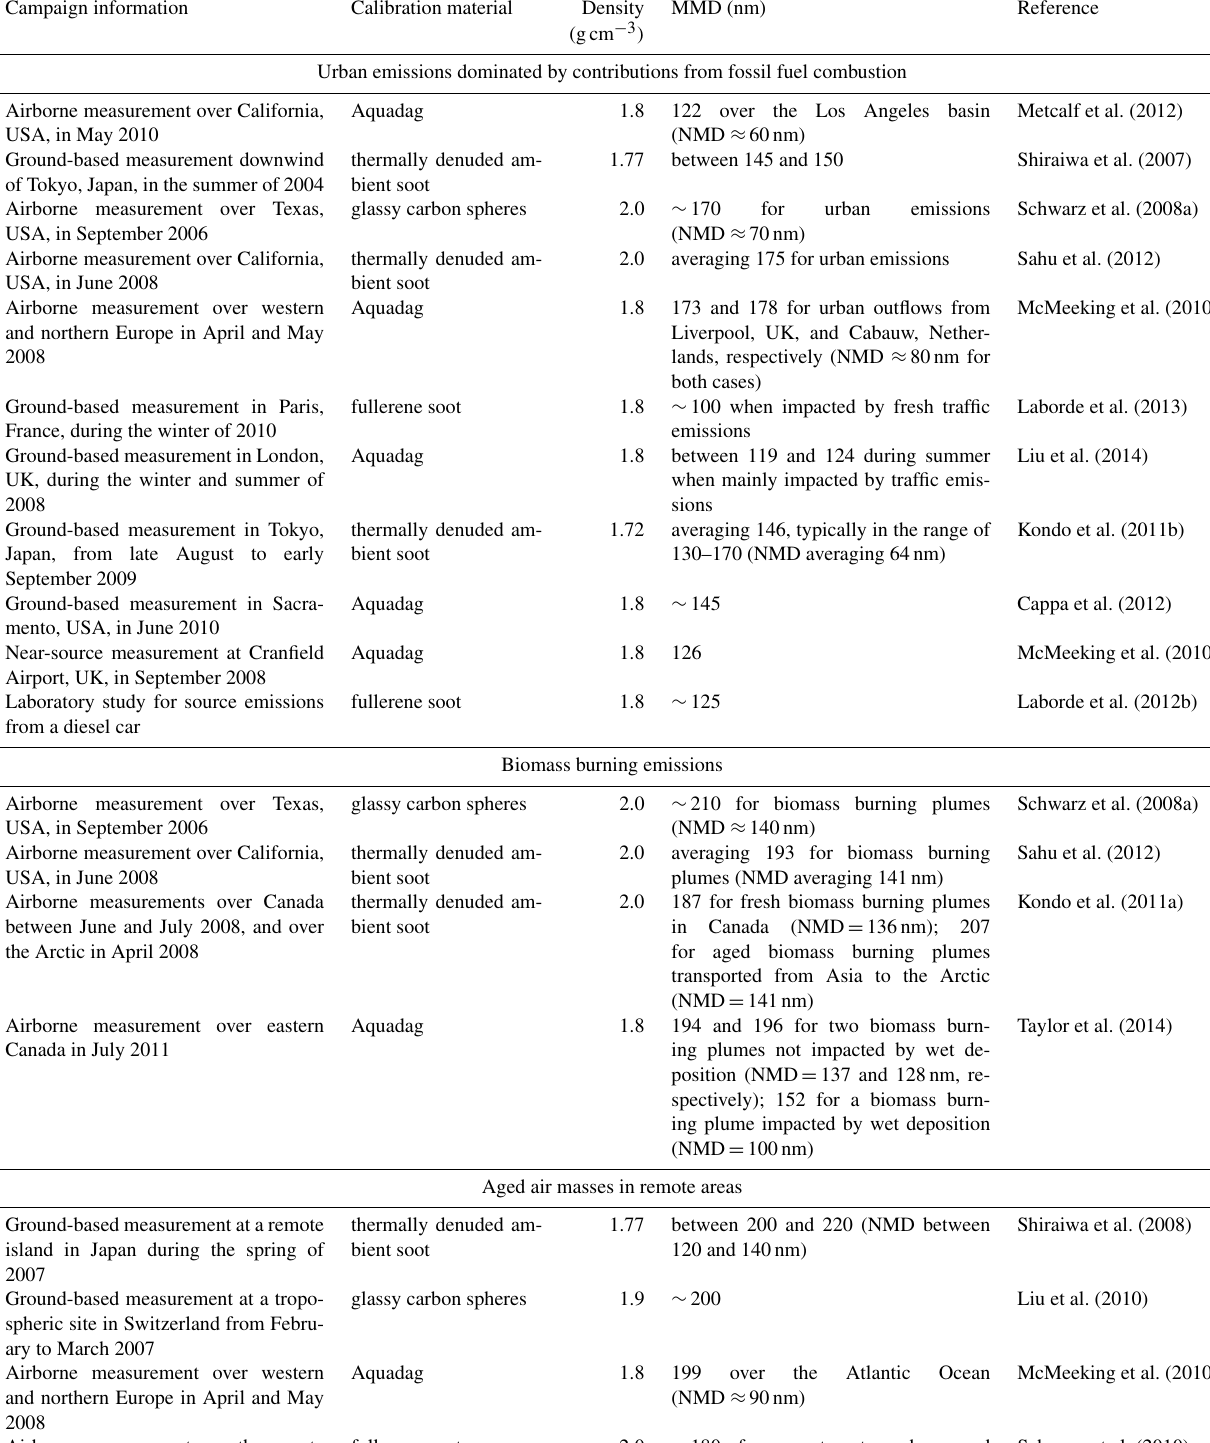
Table 1. A summary of rBC MMDs representative of different types of emission sources. The calibration material and assumed density of rBC are also shown. The corresponding rBC NMDs are presented in parentheses when